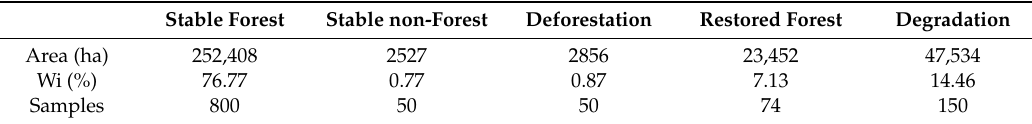
Table 2. Strata area, sample allocation for the stratified random sample, and weights for the study period